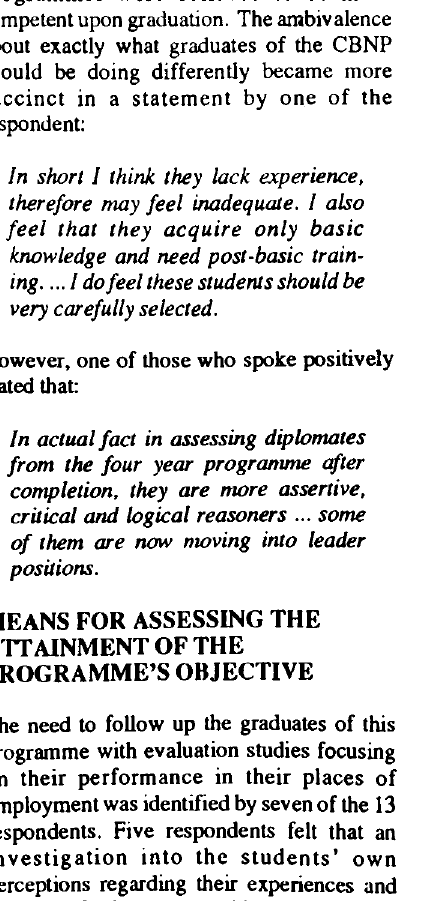
TABLE 2 Ratings of Expected Outcomes of the CBNP by Leading Nurse Educators N = 13 Expected